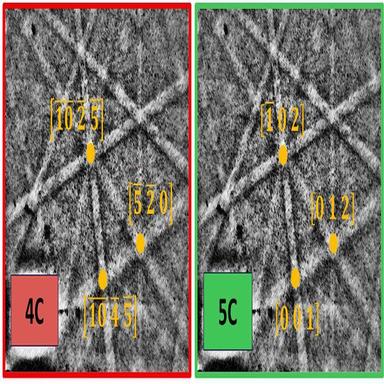
Indexing of diffracting zone axes of 4C and 5C pyrrhotite for the measured Kikuchi pattern for site A indicated in.